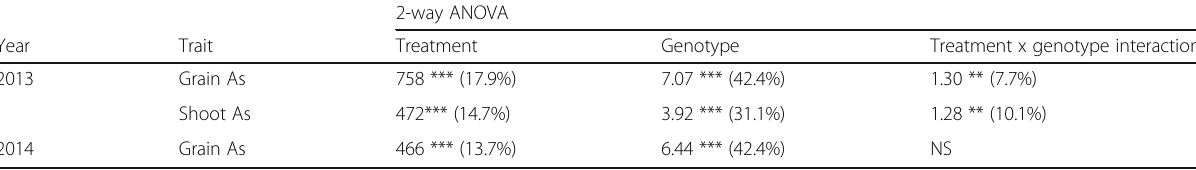
Table 2 Two-way ANOVA results (F-values) for treatment, genotype, and the treatment x genotype interaction for the grain and shoot arsenic concentrations across 2013 and 2014. Numbers in brackets are the percentage contribution for that factor to the overall variation observed